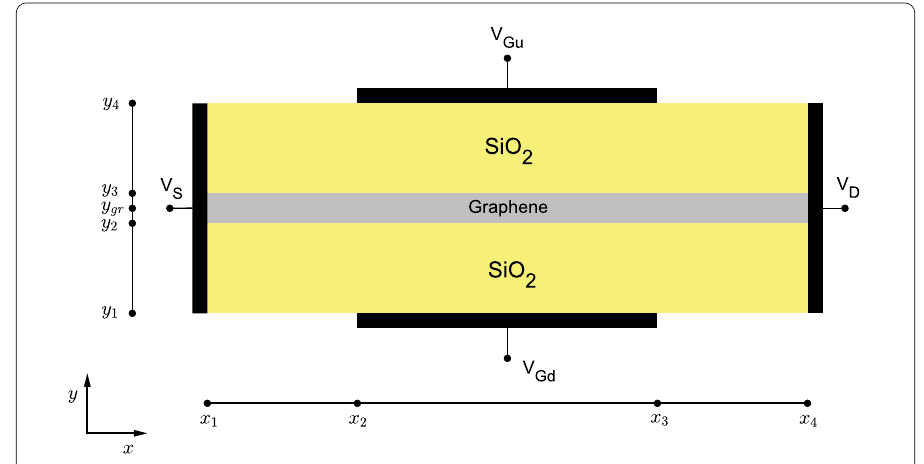
Figure 1 Schematic representation of the simulated GFET. In the direction orthogonal to the xy -plane the device is assumed infinitely